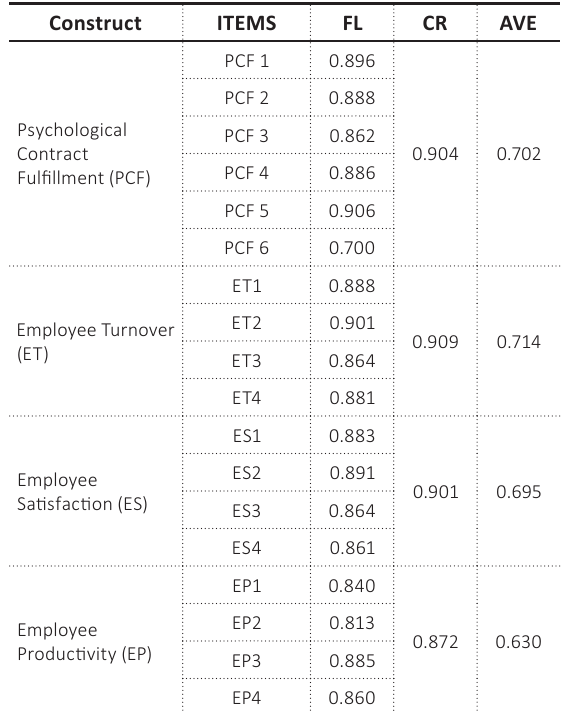
Table 2. Measurement model